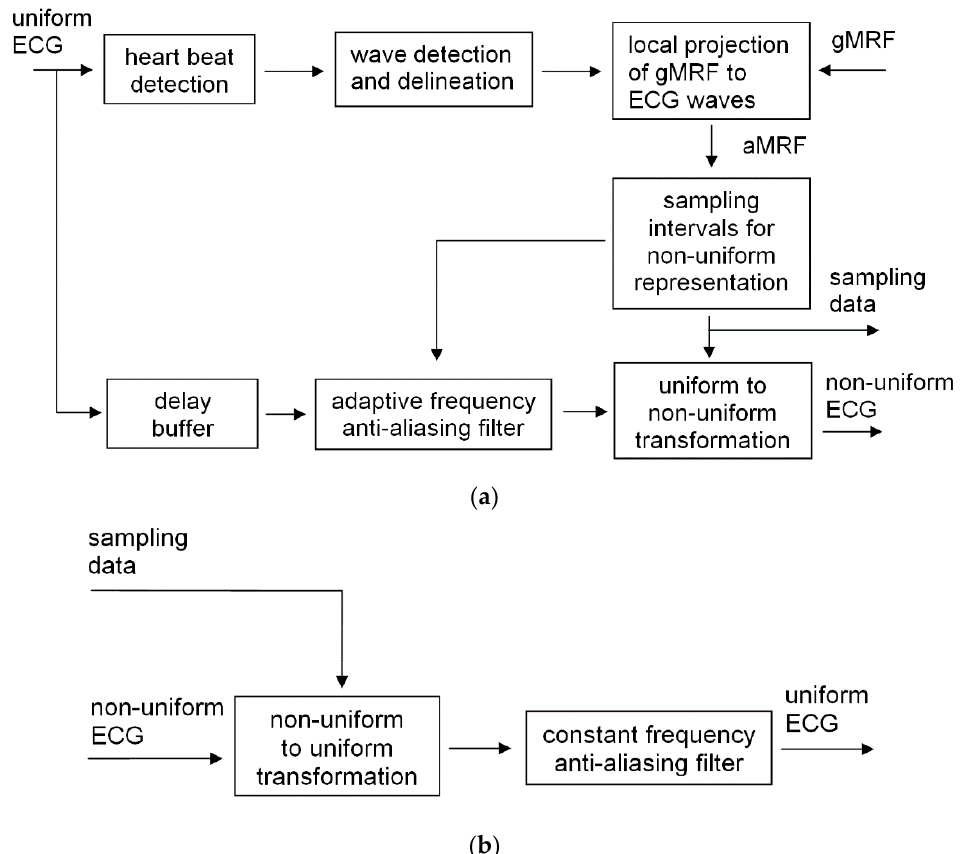
Figure 1. Block diagrams of the proposed adaptive sampling method ( a ) encoder, ( b ) decoder.